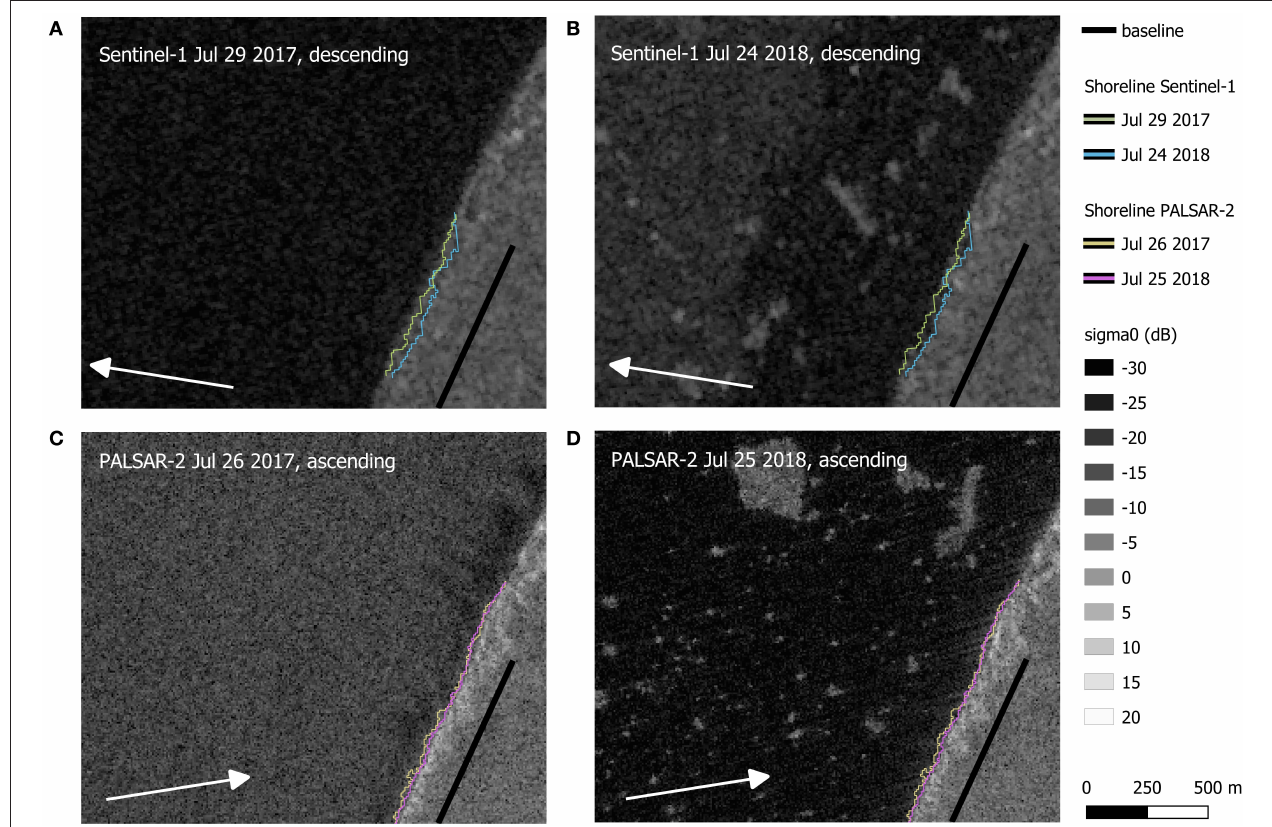
FIGURE 8 | Backscatter of Sentinel-1 (top panels (A) and (B) , acquired on descending orbit, VV polarization) and PALSAR-2 (bottom panels, (C) and (D) , acquired on ascending orbit, HH polarization) acquisitions at Avadlek (Herschel Island) for 2017 and 2018. Dates represent closest acquisitions between the two sensors for each year. Images are ellipsoid corrected only. Sensor viewing direction is indicated by arrows. Derived shorelines represent the land-water boundary. The baseline for retreat rate calculations corresponds to Figure 2A